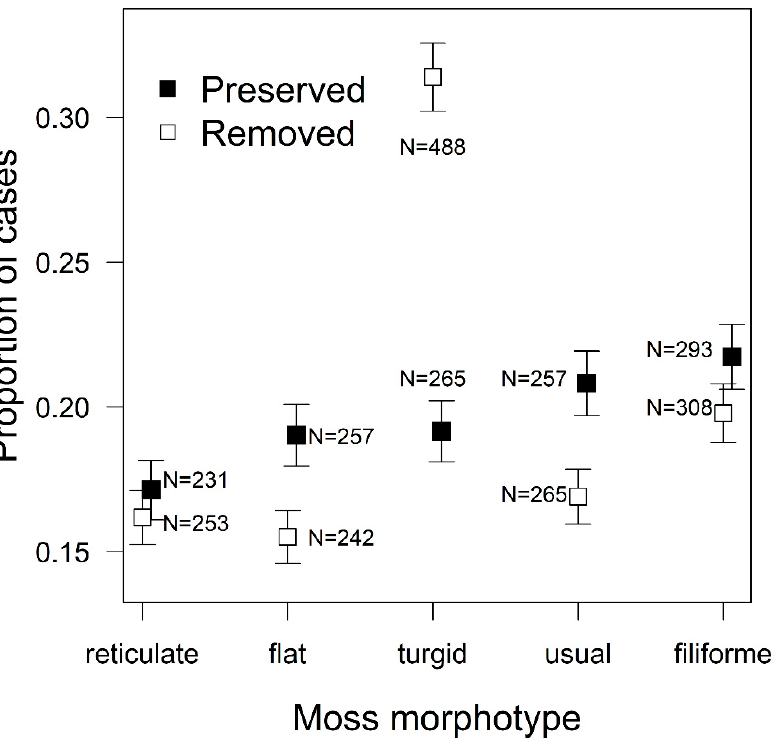
Figure 5. Proportion of cases when beetles chose the different moss morphotypes when the mosses had “preserved” or “removed” spatial structures (mean ± standard error). The differences in proportion of cases when beetles chose a particular morphotype were tested by generalized estimating equation models with binomial distribution. “N” denotes the number of positive cases when beetles chose a particular morphotype.